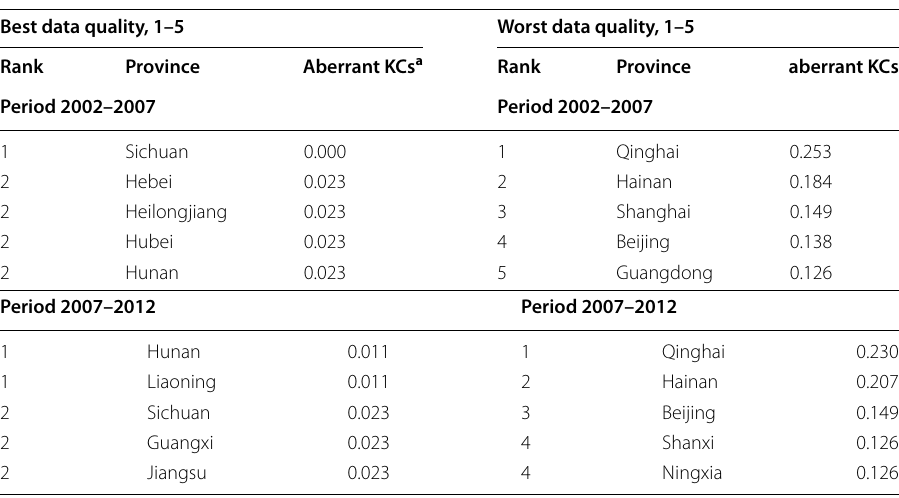
a Aberrant KCs mean the ratio of aberrant KCs to all KCs, lower is better